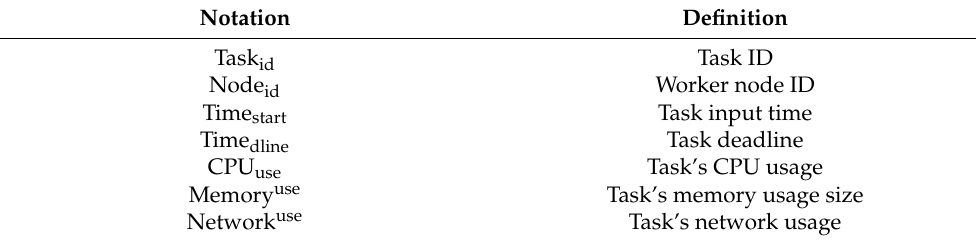
Table 2. NMonitor table